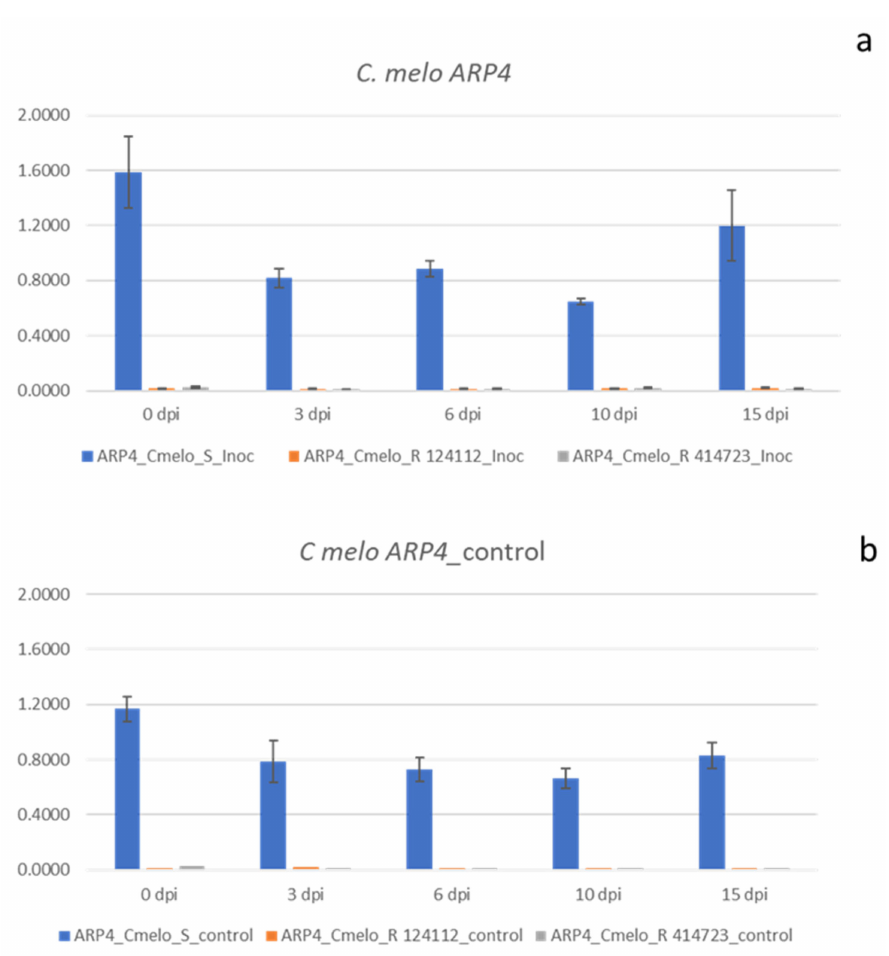
Figure 1. Expression profile of ARP4 gene in C. melo accessions. C. melo plants ToLCNDV inoculated at 0, 3, 6, 10 and 15 dpi ( a ). Control plants of C. melo accessions (non inoculated) ( b ). Student’s t test associated probability in all cases p ≤